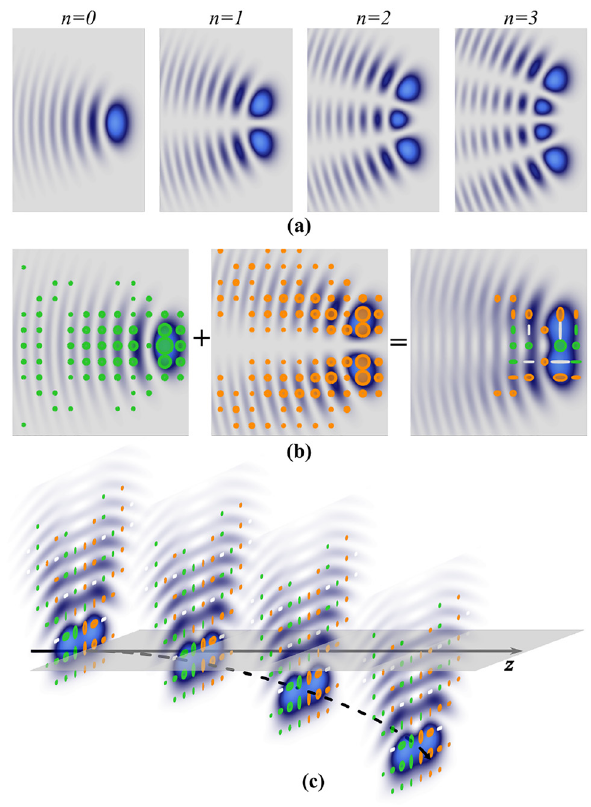
Figure 1: (a) Intensity profiles of accelerating parabolic scalar waves of orders n = { 0 , 1 , 2 , 3 } at z = 0 mm. (b) Schematic representation of the non-separable superposition of two orthogonal scalar modes carrying orthogonal polarisations to generate an accelerating vector ( 𝜂,𝜉, z ). (c) Conceptual illustration of the free-space wave AVW 0 , 1 propagation trajectory along the z -axis of the same mode shown in (b) (distances are not in scale). Green and orange ellipses represent right-handed circular polarisation (RHCP) and left-handed circular polarisation (LHCP), respectively, and white lines represent linear